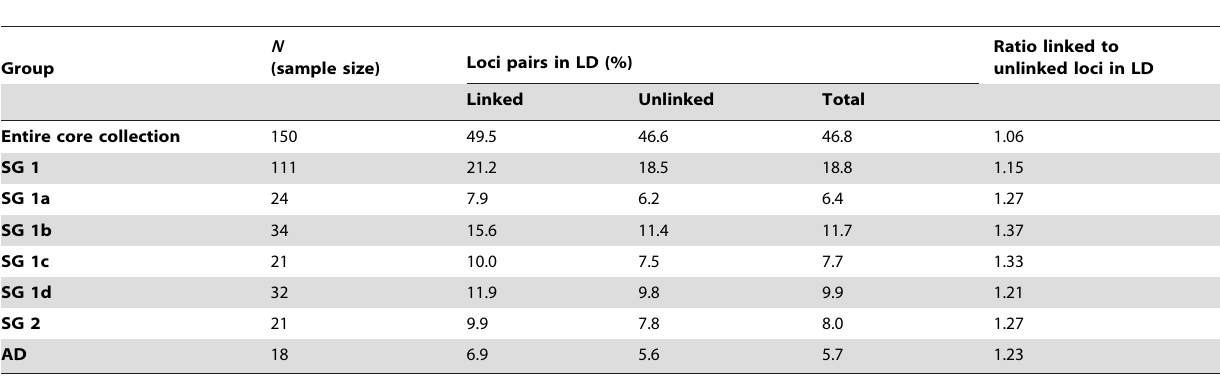
Table 5. Percentage of SSR loci pairs in significant ( P , 0.05) linkage disequilibrium (LD) in the rice core collection.